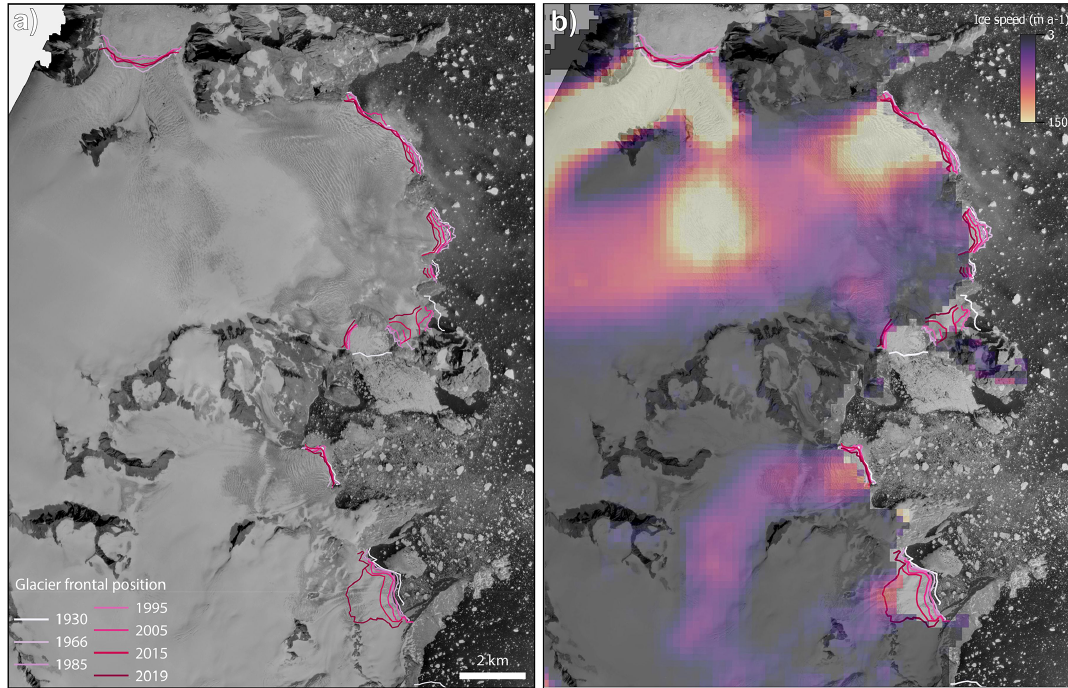
Figure 8. Position of glacier margins in part of the upper northern region (see Fig. 1). (a) Frontal positions are shown for the years 1930, 1966, 1985, 1995, 2005, 2015, and 2019. for glaciers 8, 9 and 10 as shown in Fig. 1a. (b) Frontal positions are again shown, but with colouration indicating ice velocity as well. Ice velocities derived from Joughin et al. (2010) and the background is the 1980s mosaic.